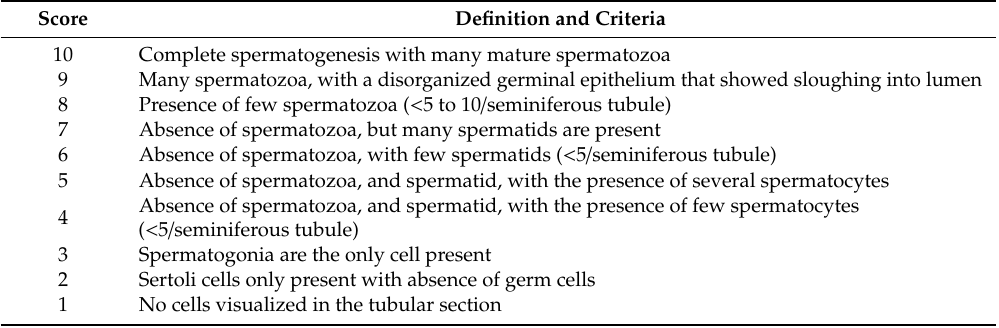
Table 2. Johnsen’s scores criteria for evaluation of spermatogenesis among studied